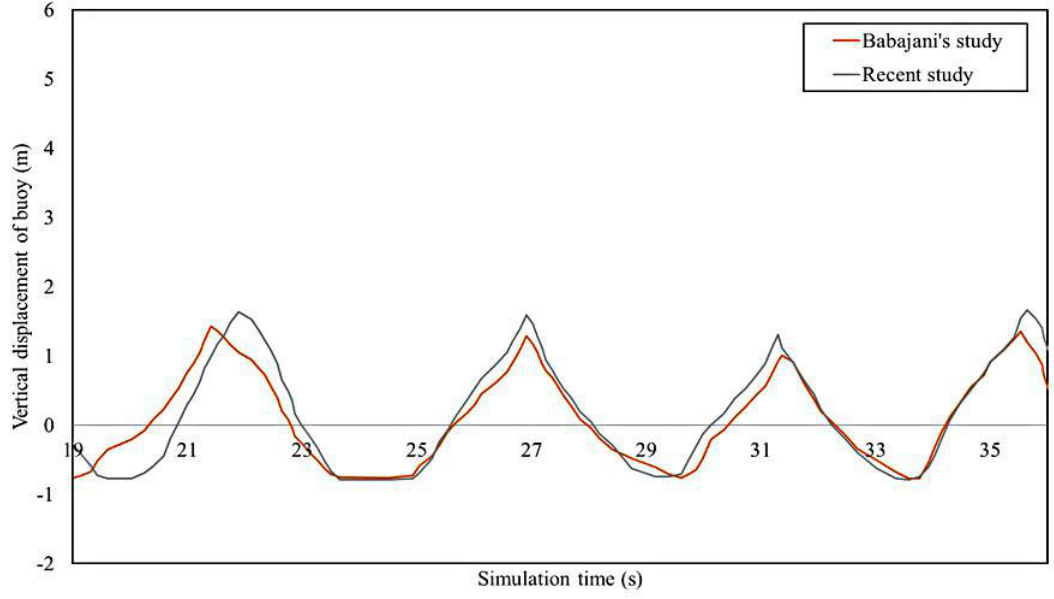
Figure 2. Validation of recent work with the former